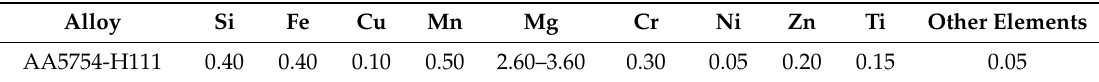
Table 1. Chemical composition of the 5754-H111 aluminium alloy.